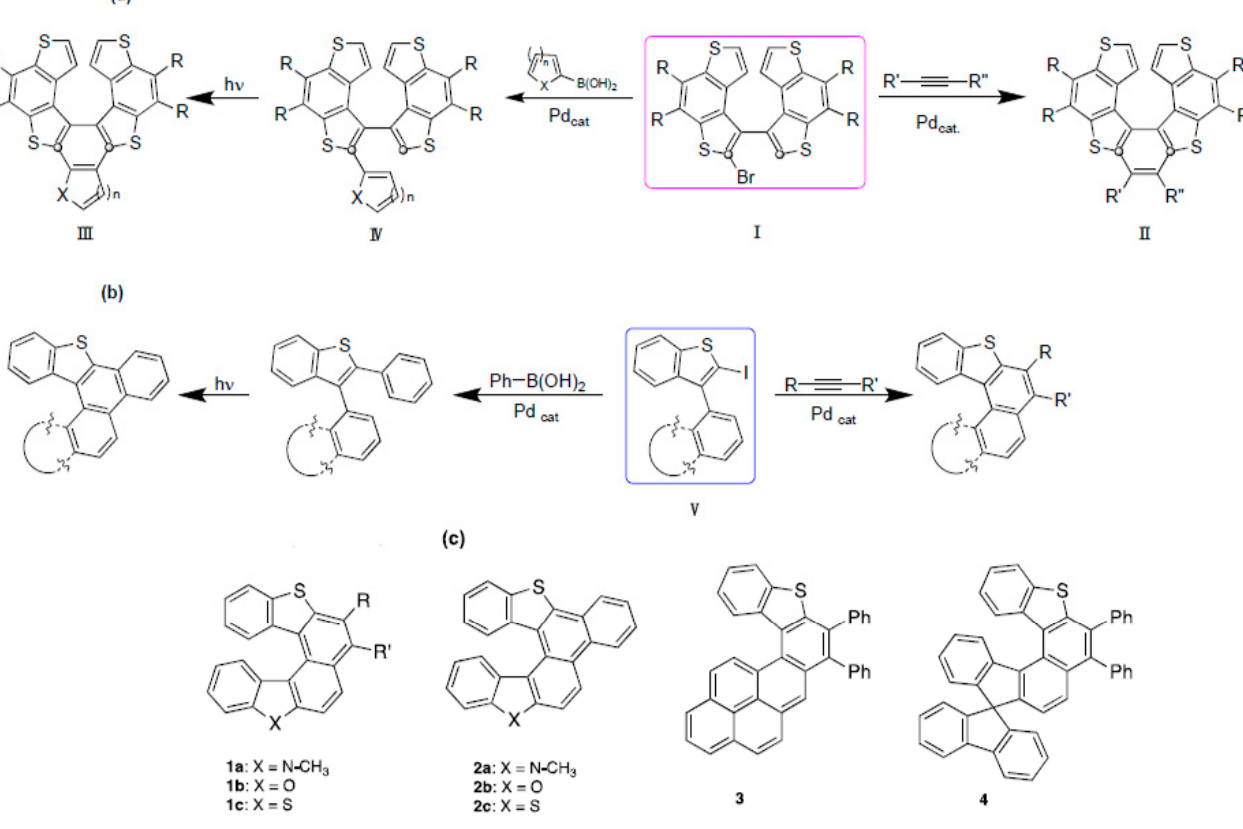
Figure 1. Synthetic strategies for the synthesis of 7-TH and novel thiahelicenes. ( a ) Previous work, ( b ) this work and ( c ) thiahelicenes developed in this